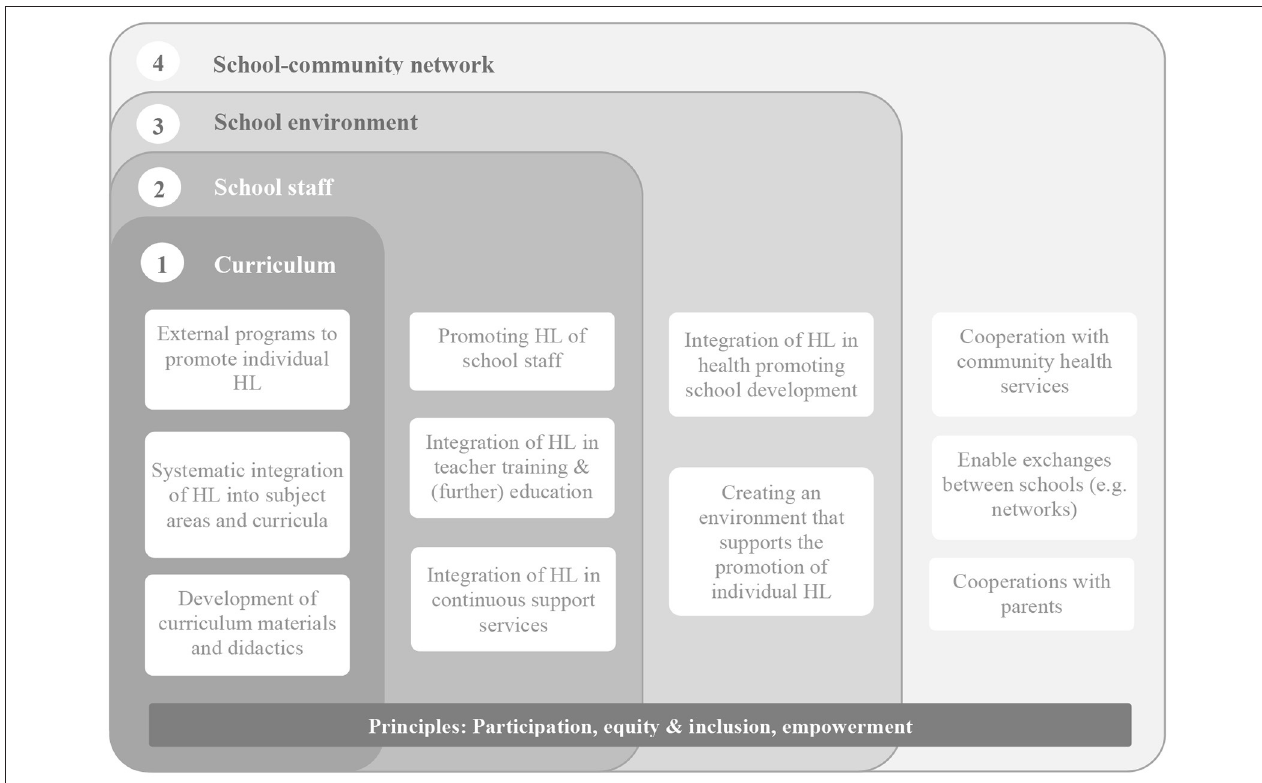
FIGURE 1 | Health literacy as part of a holistic concept of Health Promoting Schools (31,